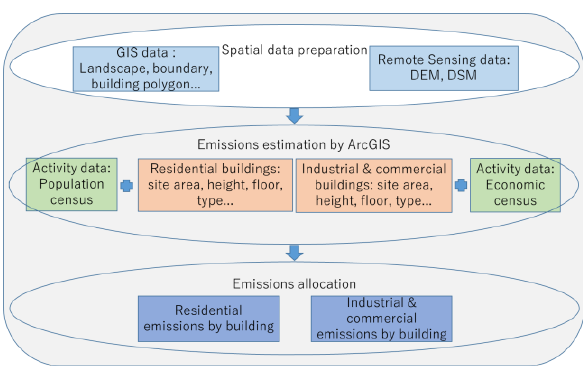
Figure 1. Conceptual framework of building emissions mapping